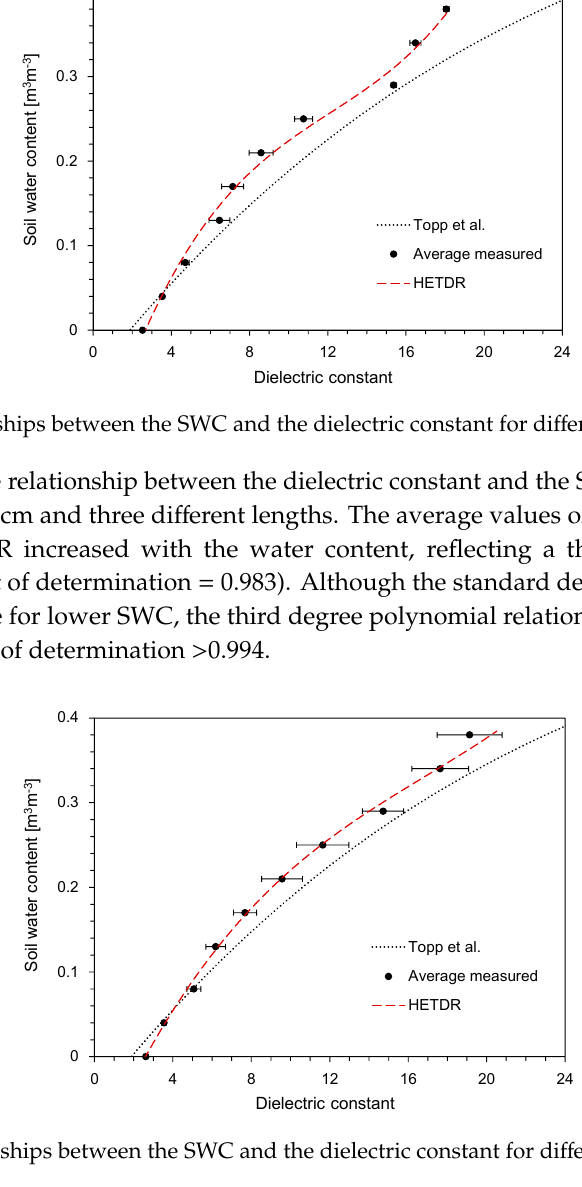
Figure 5. Relationships between the SWC and the dielectric constant for different probe lengths.